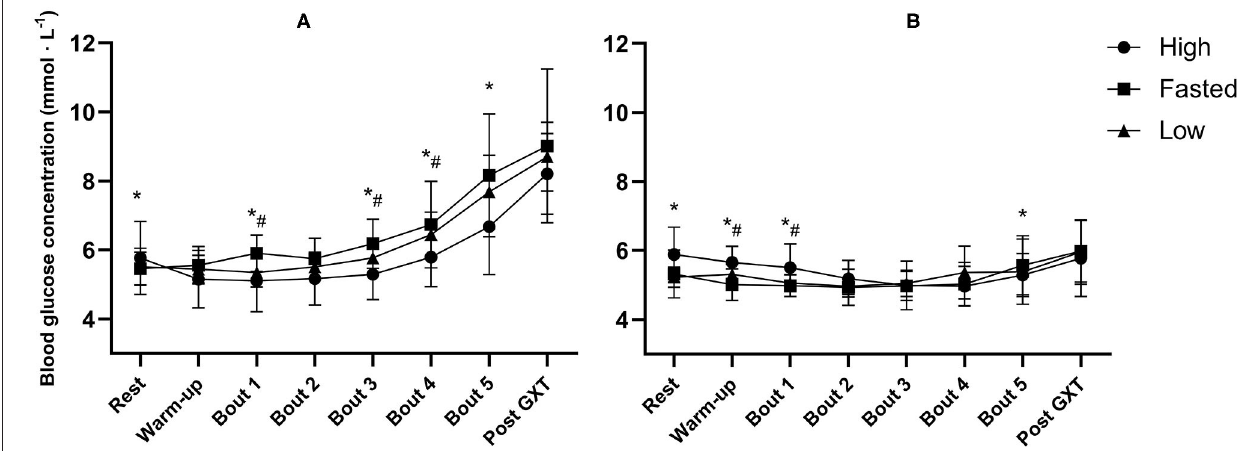
FIGURE 2 | Mean blood glucose concentrations before and after warm-up, following all five 5-min exercise bouts at ∼ 50, 60, 70, 80, and 90% of ˙VO 2max , and after the graded exercise test (GXT) in well-trained (A) and recreationally trained (B) . High, pre-event meal with high carbohydrate content; low, pre-event meal with low carbohydrate content; fasted, test in fasted state. *significant effect of pre-event meals after a follow-up test with both groups included ( p ≤ 0.05), *#significant effect of pre-event meals after a follow-up test for the two groups separately ( p ≤